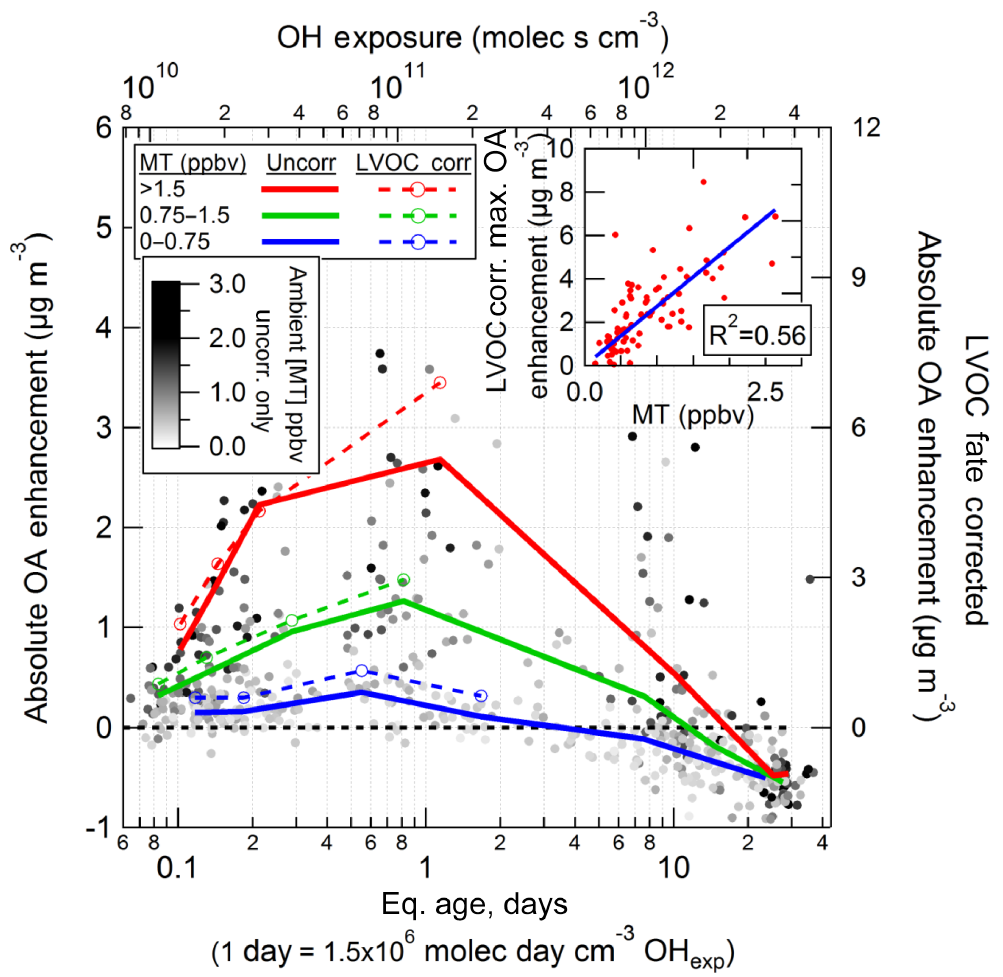
Figure 8. OA enhancement from OH oxidation of ambient air using the OFR185 method as a function of photochemical age. All data points (uncorrected only) are shown, shaded by in-canopy MT concentrations. Average OA enhancements of age quantiles with equal number of data points with (right axis, dashed lines) and without (left axis, solid lines) the LVOC fate correction are also shown, separated into low (0 to 0.75ppbv), medium (0.75 to 1.5ppbv), and high (>1.5ppbv) ambient MT concentration ranges. The inset shows the correlation ( R 2 = 0 . 56) between the LVOC fate corrected maximum OA enhancement (0.4–1.5 eq. days of aging) and in-canopy MT